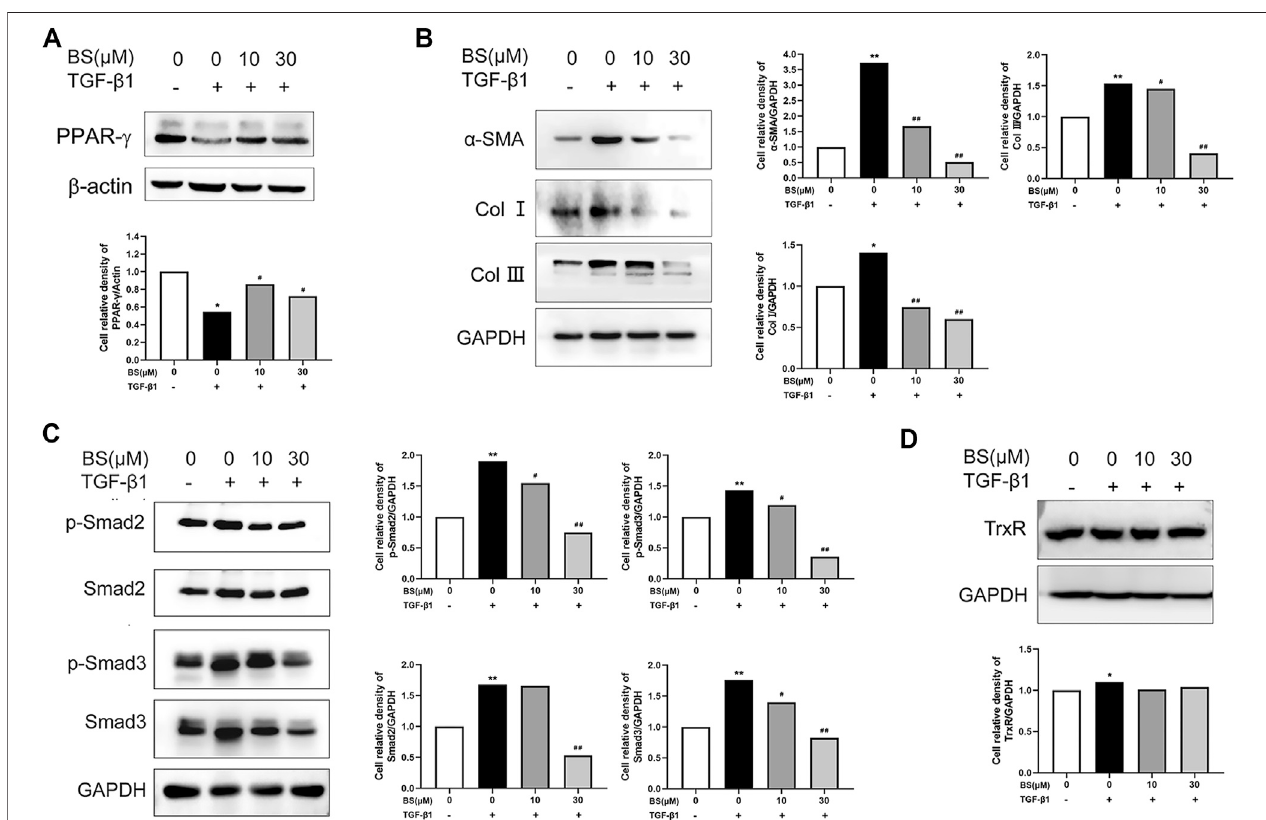
FIGURE4| BSinhibitedtheexpressionsof fi brosis-relatedproteins invitro .HSCswereincubatedwithorwithoutBSand5 ng/mlTGF- β 1. (A) Theproteinlevelsof PPAR- γ as measured by western blot analysis. (B) The protein expressions of α -SMA, Col Ⅰ , and Col III as measured by Western blot analysis. (C) The protein expressions of p-Smad2, Smad2, p-Smad3, and Smad3 as measured by Western blot analysis. (D) The protein expression of TrxR as measured by Western blot analysis. Data were shown as mean ± SD, n ≥ 3 and analyzed with the one-way ANOVA. * p < 0.05, ** p < 0.01, TGF- β 1 positive, 0 μ M BS groups versus TGF- β